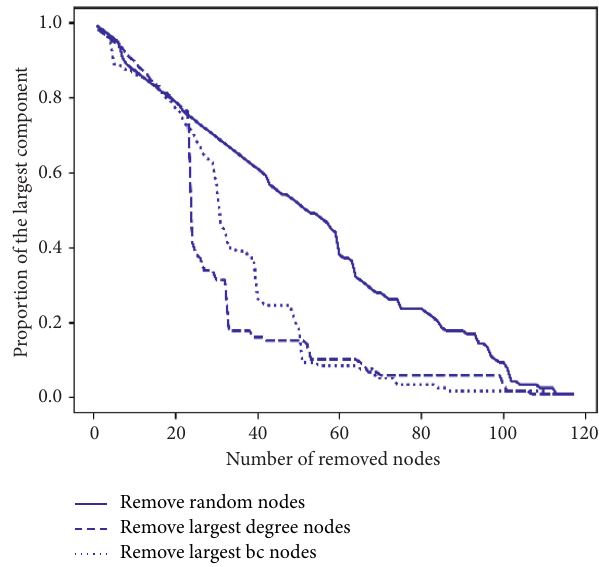
Figure 7: Robustness analysis under node